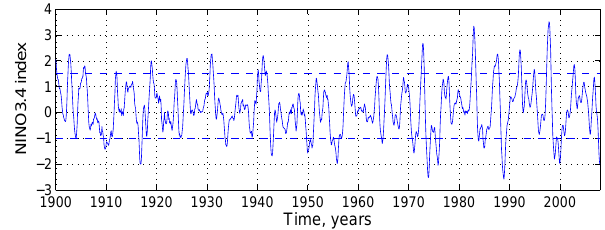
Fig. 1. Temporal evolution of the NINO3.4 index that summa- rizes sea-surface temperature (SST) anomalies in the region be- tween 170 ◦ ,W–120 ◦ W and 5 ◦ S–5 ◦ N. The time series is centred and normalized, but the horizontal lines do not represent the stan- dard deviations: instead, they have ordinates 1.5 and − 1; see also Fig.